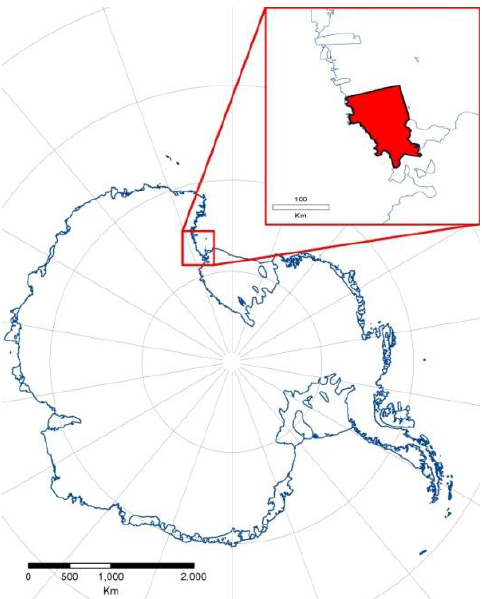
Figure 1. McMurdo Sound in relation to the Antarctic continent.